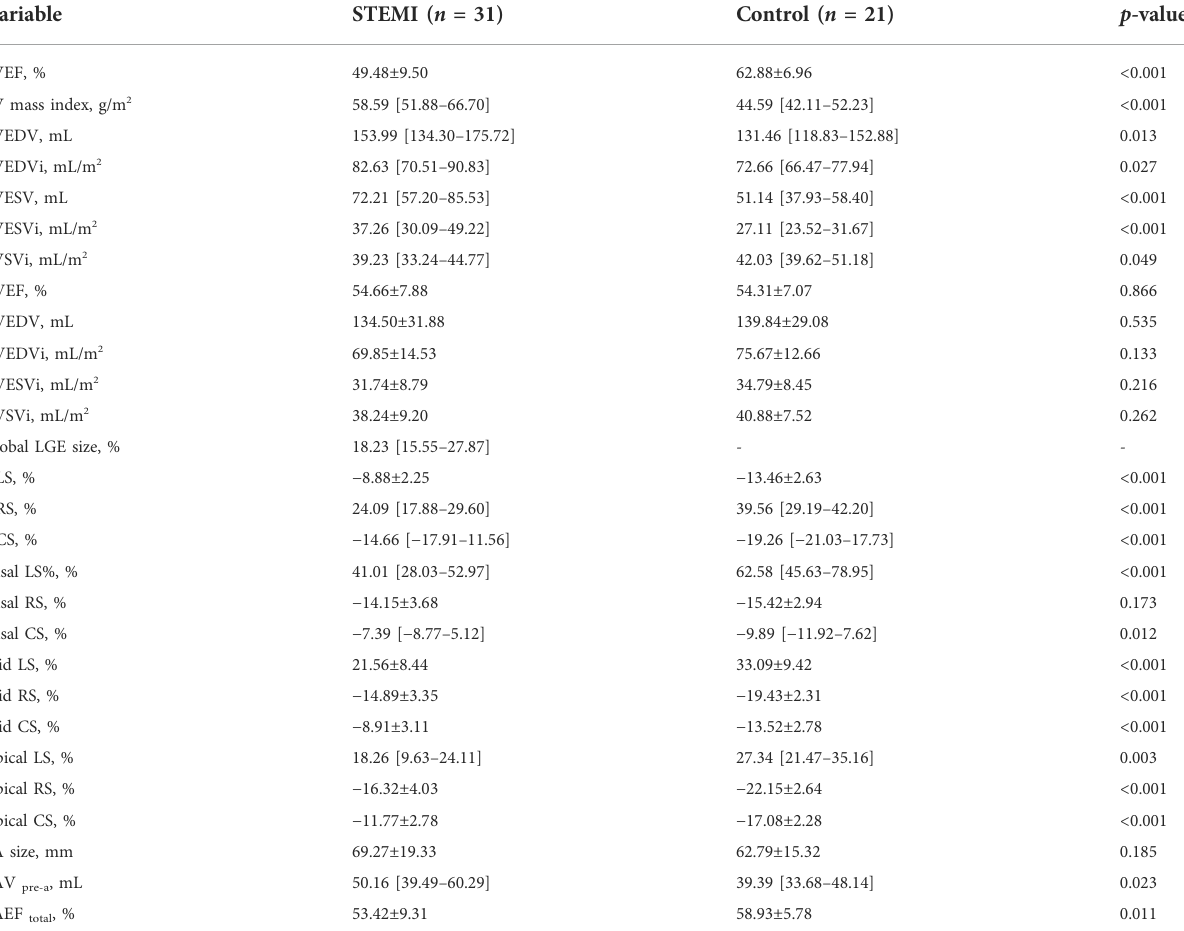
TABLE 2 CMR parameters of the study